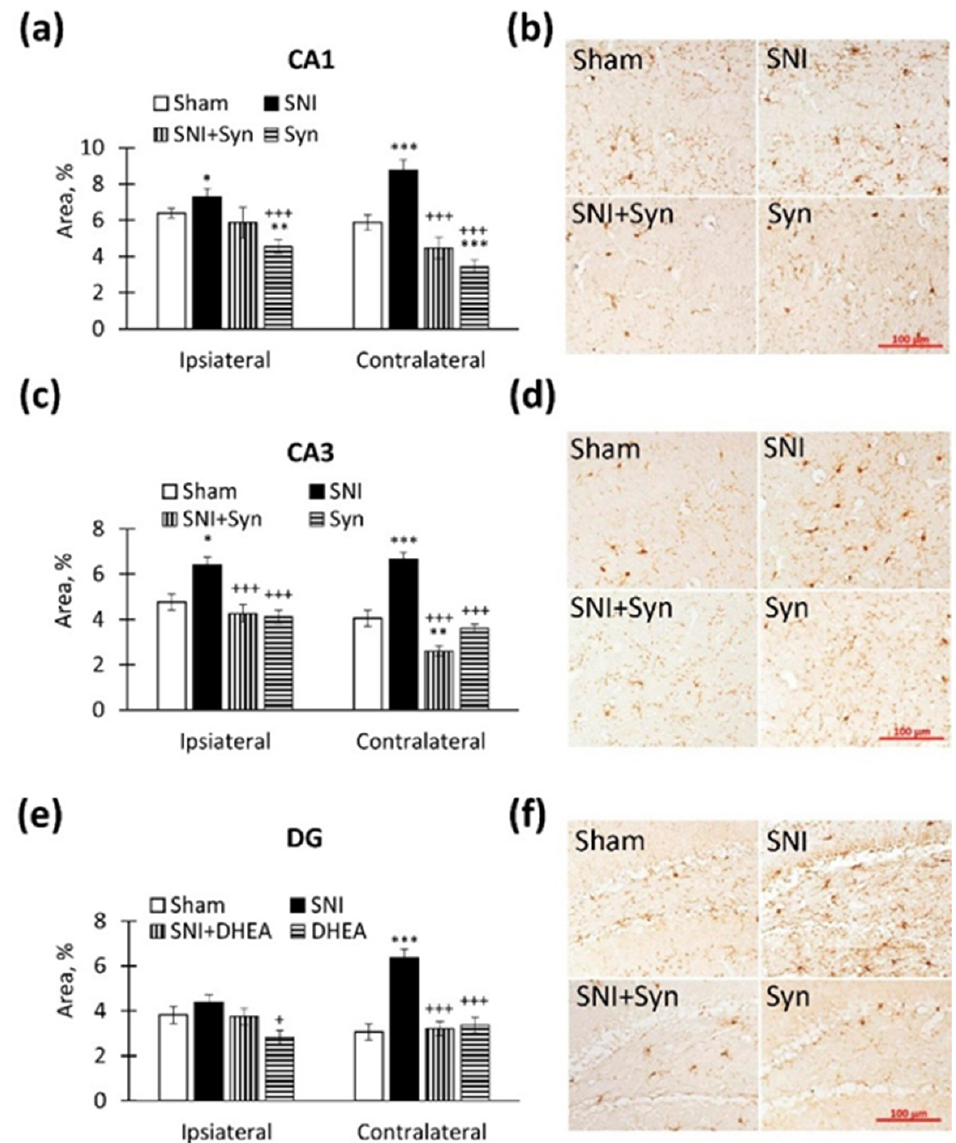
Figure 4. Iba-1 immunoreactivity in CA1, CA3 и DG hippocampal regions. ( a ) The percentage of Iba-1 immunopositive staining area in CA1 hippocampal region. ( b ) Representative images of Iba-1-positive immunostaining in CA1 hippocampal region. Scale bar — 100 µ m. ( c ) The percentage of Iba-1 immunopositive staining area in CA3 hippocampal region. ( d ) Representative images of Iba-1-positive immunostaining in CA3 hippocampal region. Scale bar — 100 µ m. ( e ) The percentage of Iba-1 immunopositive staining area in DG hippocampal region. ( f ) Representative images of Iba-1-positive immunostaining in DG hippocampal region. Scale bar — 100 µ m. Two-way ANOVA with post hoc Tukey test, * p < 0.05, ** p < 0.01, *** p < 0.001; + p < 0.05, ++ p < 0.01, +++ p < 0.001. *-compared to “Sham”, + -compared to